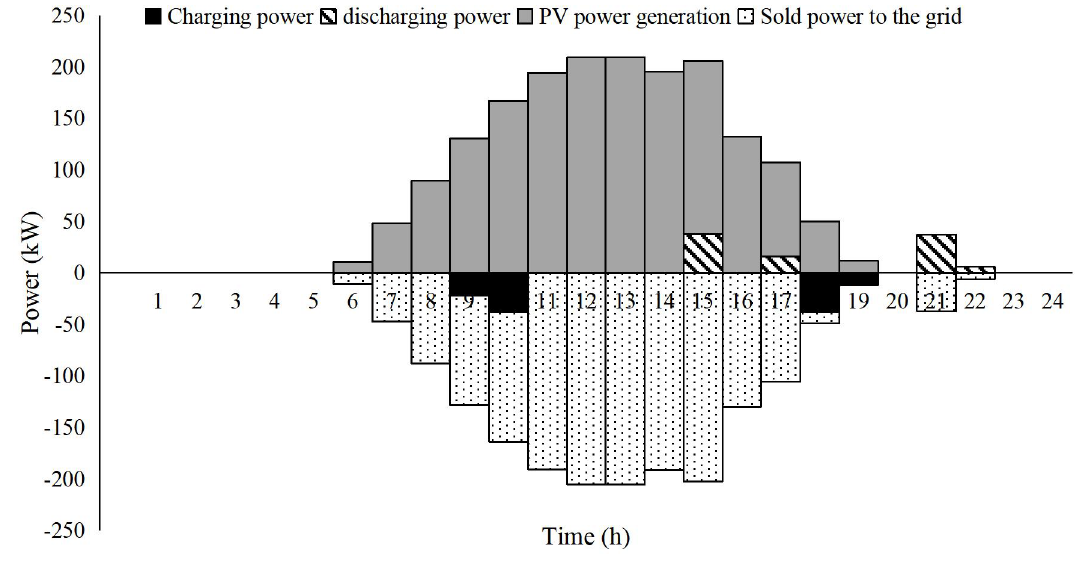
Figure 5. The power balance of the PV system in Case I in Zone 1 on a summer day.